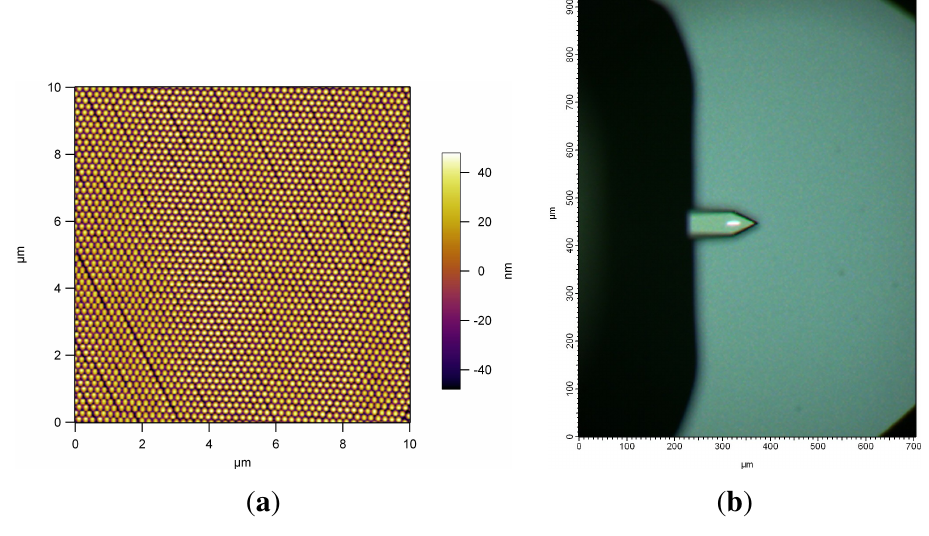
Figure 8. AFM height profile of PS NP monolayer obtained from spin-coating at 300 rpm on a freshly etched Si-wafer ( a ); optical microscopy image of the nanoparticle monolayer prior to investigation by AFM. The uniform coloration due to optical interference from the monolayer manifests the homogeneity of the film ( b